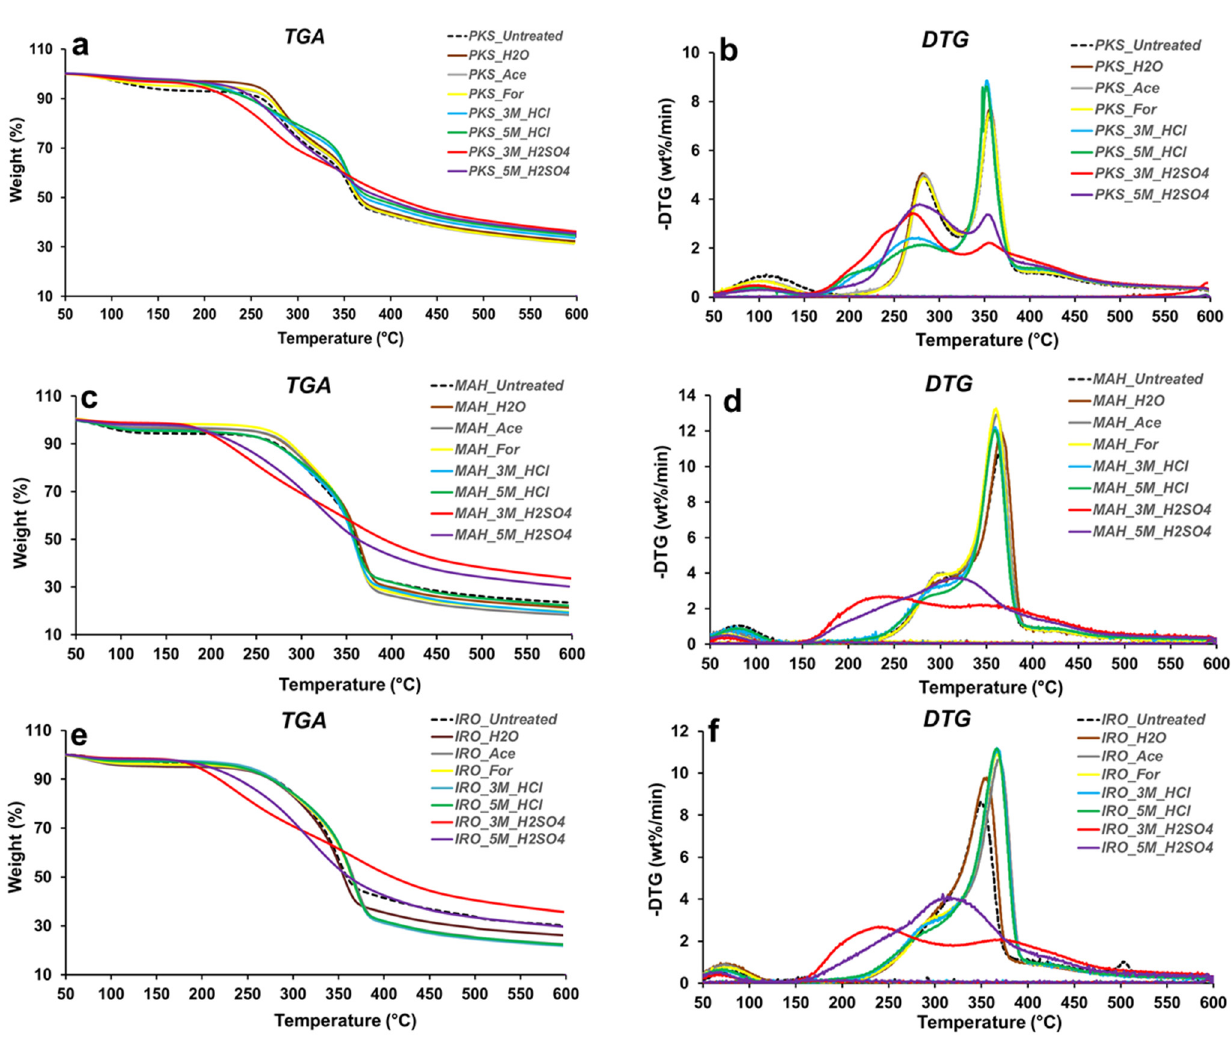
Figure 4. Thermogravimetric analysis (TGA) and differential thermogravimetic (DTG) curves of raw and pretreated PKS ( a , b ), MAH ( c , d ) and IRO ( e , f ).